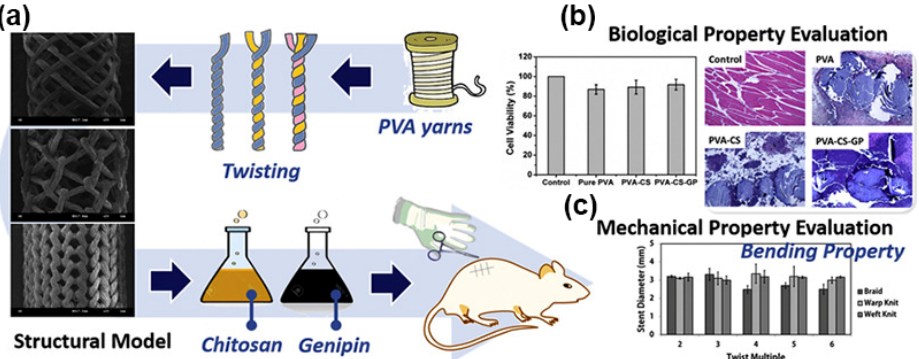
Figure 3. Schematic illustration for the formation and evaluation of a PVA stent. ( a ) The design and processing of the PVA stent. ( b ) The biological property evaluation of the PVA stent. ( c ) The mechanical property evaluation of the PVA